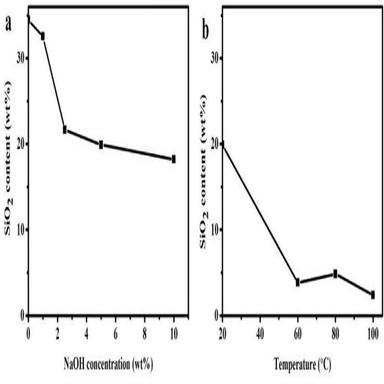
Plots of the relationship between silica content and (a) NaOH concentration, (b) reaction temperature.